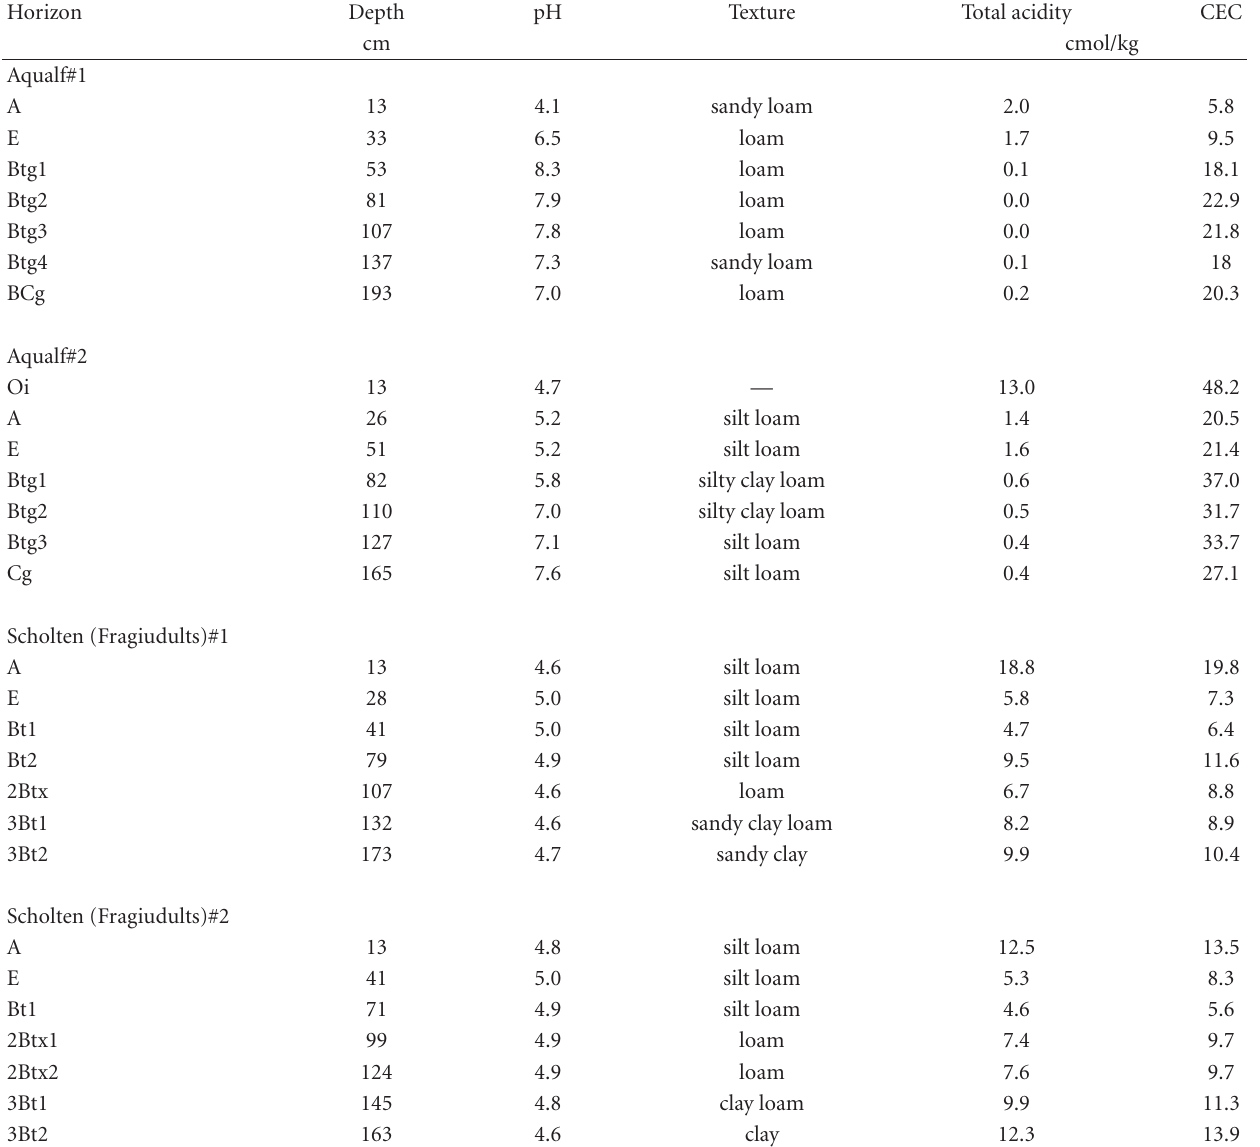
Table 1: Soil profile characterization.